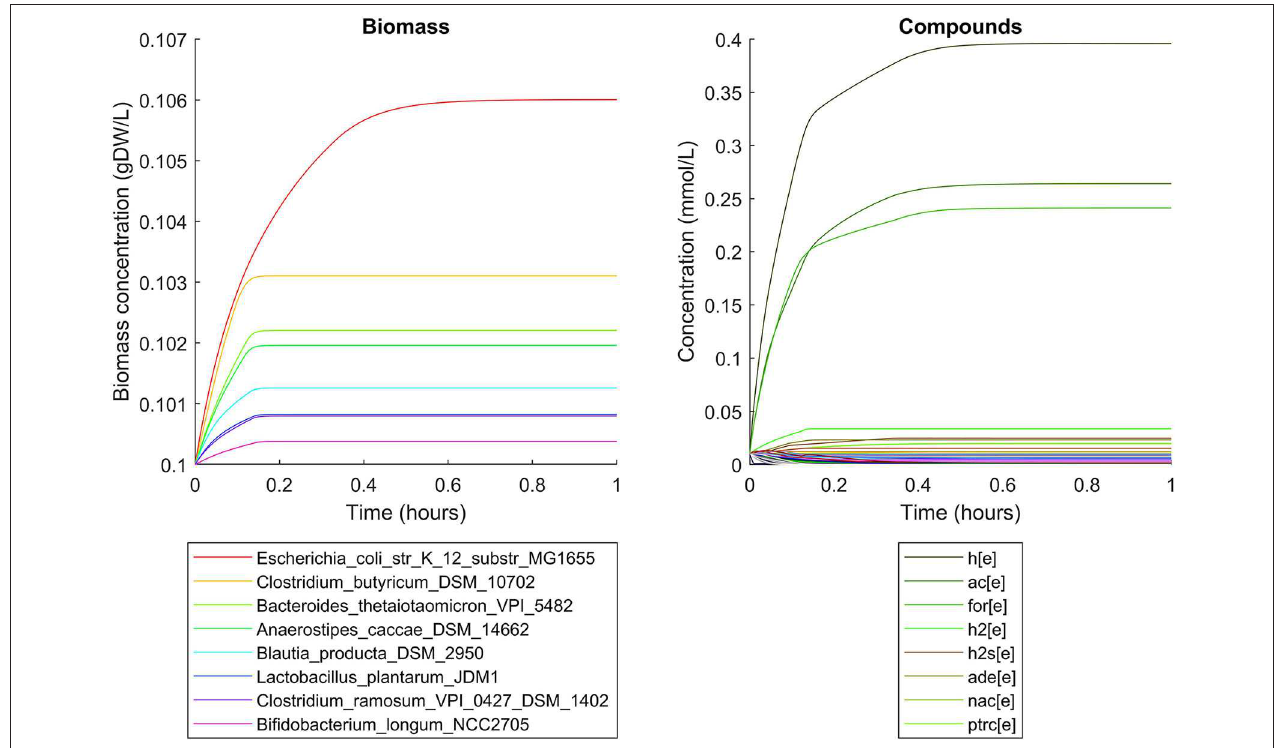
FIGURE 4 | Simulating the SIHUMIx community consisting of 8 microbial species as a batch, using identical initial biomass concentrations for all species and identical compound concentrations for all compounds. The legend for compounds only contains the 8 most abundant compounds (out of 139) at the end of the simulation with abbreviations h[e]: proton, ac[e]: acetate, for[e]: formate, h2[e]: hydrogen, h2s[e]: hydrogen sulfide, ade[e]: adenine, nac[e]: nicotinate, ptrc[e]: